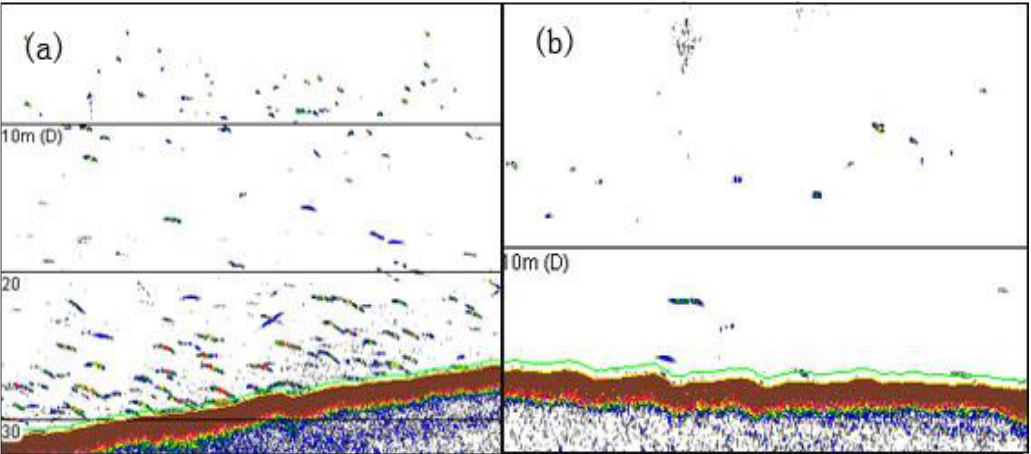
Figure 3. Echogram showing two types of fish distribution patterns at different depths. ( a ) Fish assembled; ( b ) fish dispersed.